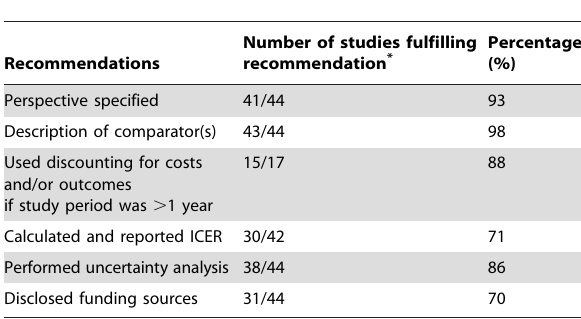
Table 3. Extent to which the studies included met recommendations for reporting of economic evaluations.